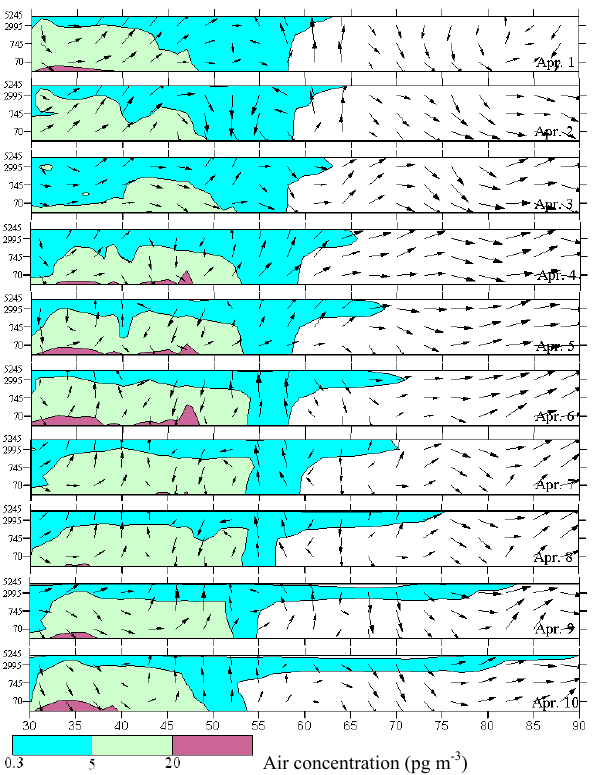
Fig, 6 Fig. 6. Vertical cross section of MEDIA modeled zonal-mean daily α -HCH air concentration (pgm − 3 ) from the surface to 5200m height for 1–10 April 1997, averaged over longitude 110 ◦ E to 140 ◦ W. Figure also shows cross-section of daily zonal-averaging vector winds by mean meridional wind and vertical velocity over the same region and over the same period. In the presentation of the vector winds, the vertical velocity w is multiplied by 100.